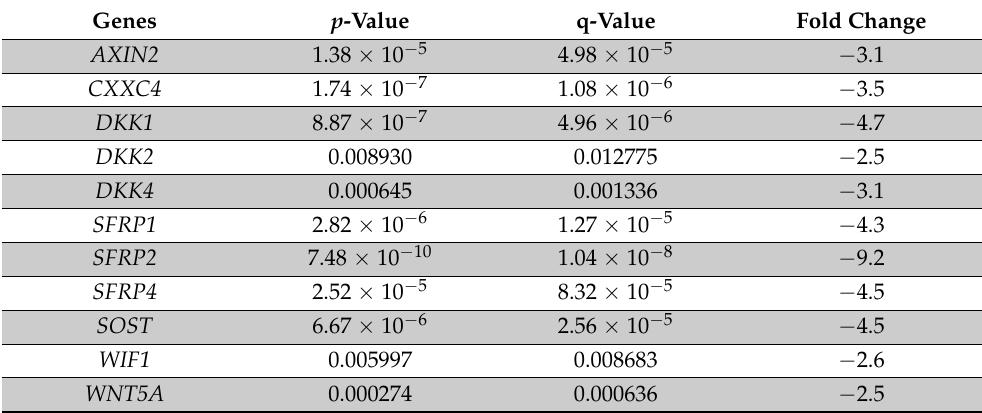
Figure 1. The hierarchical clustering analysis of the differential gene expression pattern between normal controls, elderly AML patients, and pediatric AML patients. Table 1. Distinct lower mRNA expression of the selected Wnt / β -catenin pathway inhibitors in elderly AML patients compared to pediatric AML